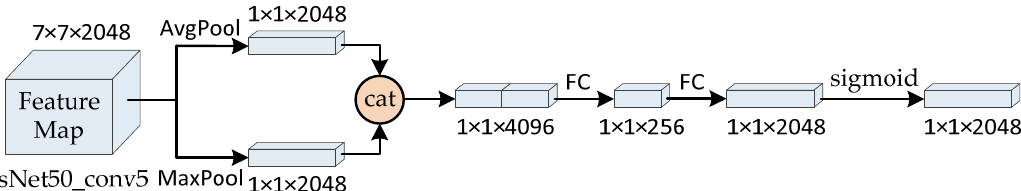
Figure 4. The structure of channel attention mechanism. FC denotes full connection, cat denotes catenation.